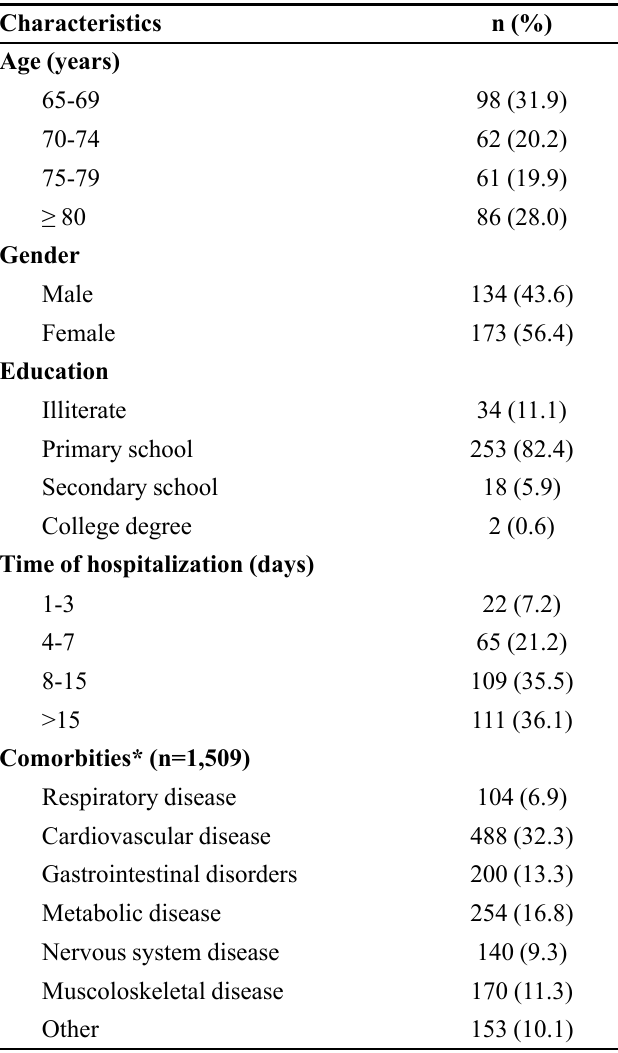
TABLE I - Characteristics of the surveyed elderly hospitalized, from February through September 2016. Tubarão (SC), Brazil. (n =